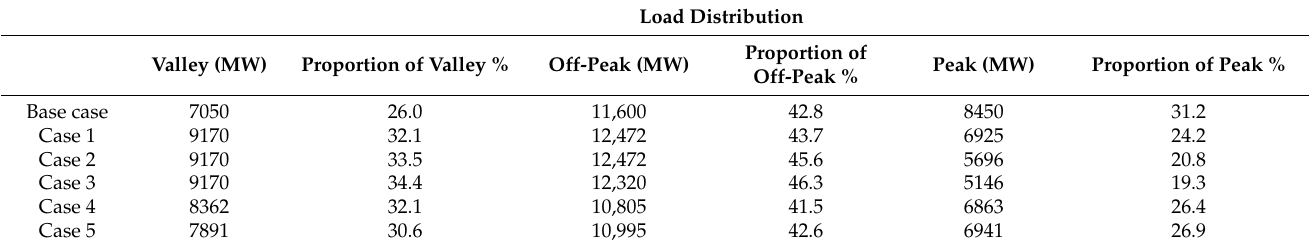
Table 7. Proportion of load demand in each